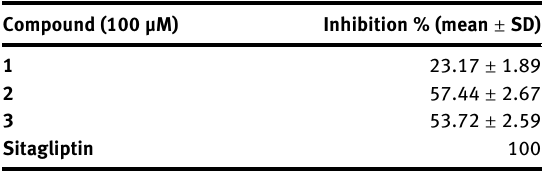
Table  : DPP-  inhibitionpercentages(%)ofcompounds  –  .